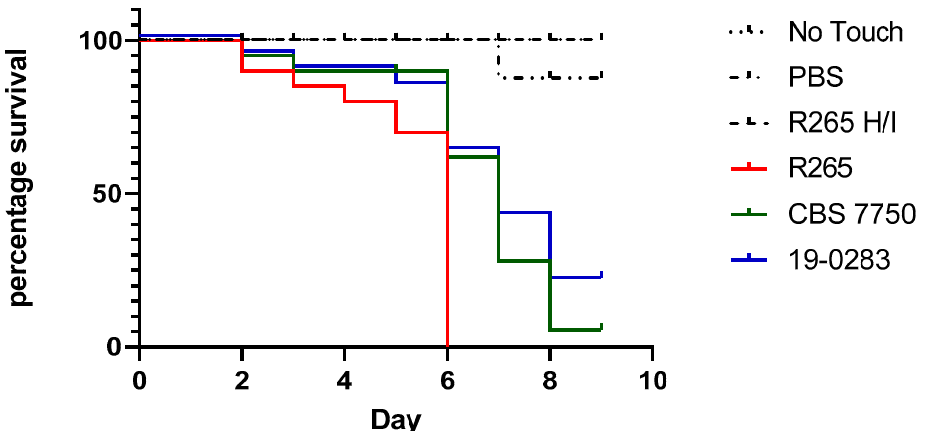
Figure 3. Kaplan–Meyer survival curves of Galleria mellonella larvae injected with different C. gattii complex isolates and controls (20 larvae per group and experiment). The isolate from Bolivia (19-0283) is represented by the blue line, while C. gattii VGII reference strains R265 (high virulence) and CBS 7750 (low virulence) are shown as red and green lines, respectively. Control groups were either non-manipulated larvae (No Touch), or larvae injected with PBS or heat-inactivated (H/I) R265 (black dotted lines). The graph and statistical analysis were performed in Graphpad prism 8.4. The figure represents one of three biological replicates demonstrating equal outcomes.